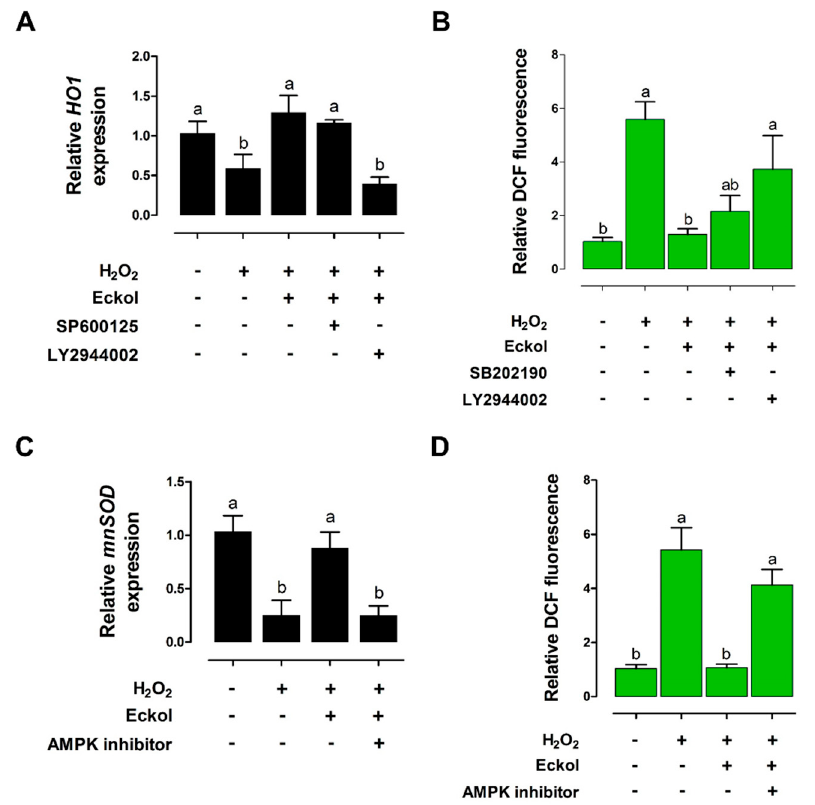
Figure 7. Eckol protects against H 2 O 2 -induced oxidative stress in IPEC-J2 cells. Relative HO-1 ( A ) and MnSOD expression levels ( C ) were evaluated through qRT-PCR (n = 3). Relative cellular ROS ratio was determined through 2’,7’-dichlorofluorescein (DCF) fluorescence analysis with or without PI3K / AKT (LY2944002), P38 (SB202190) ( B ), or 5’-AMP-activated protein kinase (AMPK) ( D ) inhibitor (n = 3)